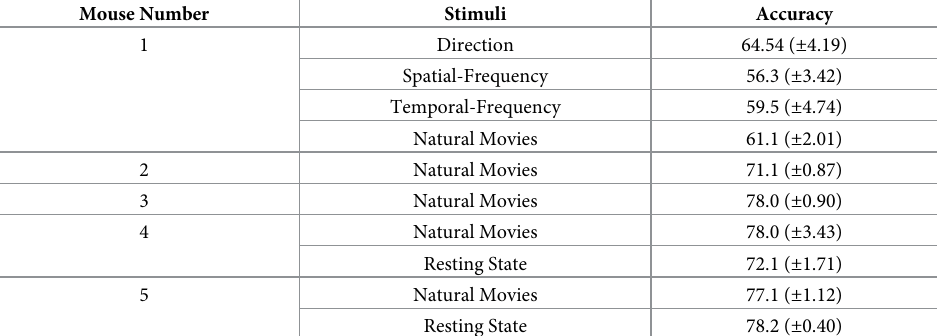
Table 5. Accuracy of semi-supervised segmentation on wide-field dataset. The results are averaged across random initializations of UBM. The entries denote “ % accuracy (± standard deviation) ”.